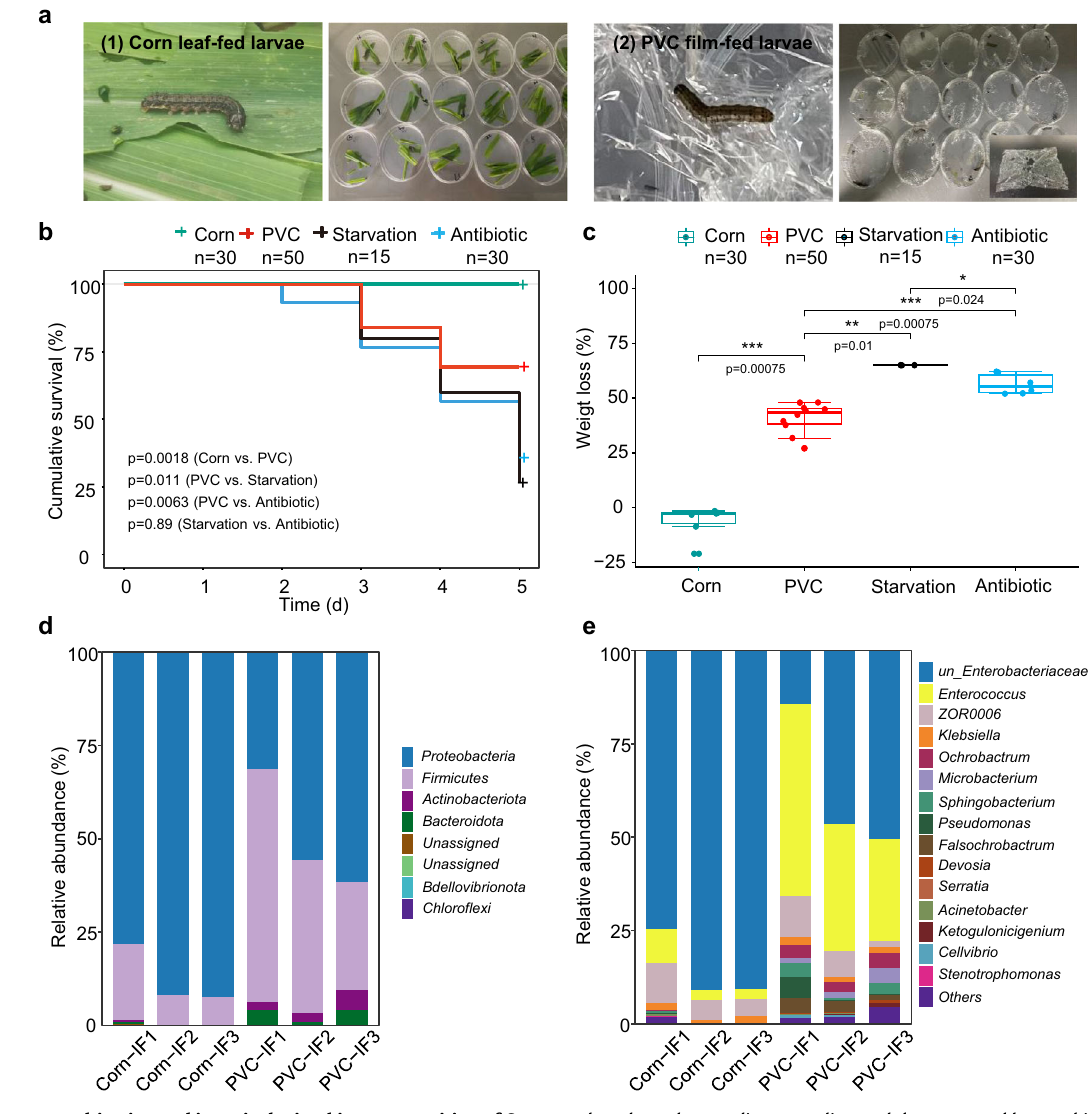
plots showed center line as median, and the upper and lower whiskers show maximaand minima,and boxlimitsshow upperand lowerquartiles.Wilcoxontest was used to identify the difference in weight loss ( c ) between groups. Both statis- ticaltestsweretwo-sidedand P values(*** ≤ 0.001 ≤ ** ≤ 0.01* ≤ 0.05)wereadjustedby Benjamini – Hochberg (BH) multiple testing. d , e Intestinal microbiota composition at the phylum ( d ) and genus ( e ) levels. Source data are provided as a Source Data fi